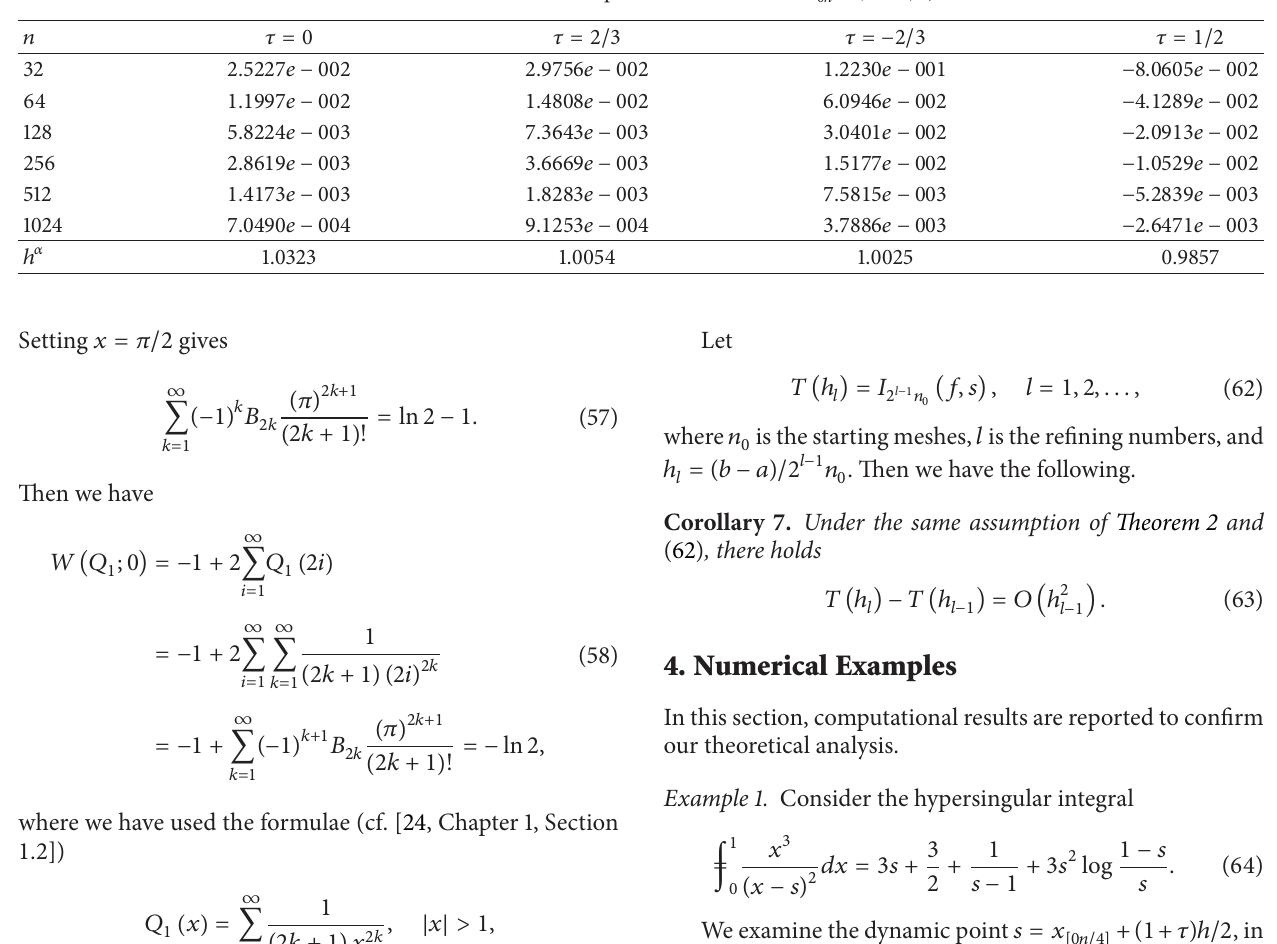
Table 2: Errors of the mod-trapezoidal rule with 𝑠 = 𝑥 0𝑛 − (1 + 𝜏)ℎ/2